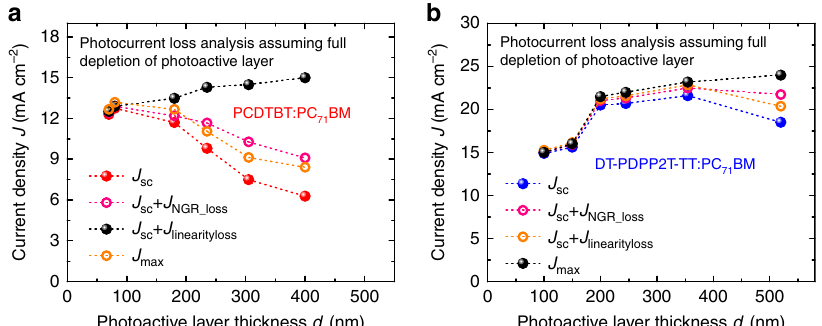
Fig. 2 Photocurrent analysis at short-circuit condition. a Photocurrents of PCDTBT:PC 71 BM are plotted device as a function of photoactive layer thickness: red balls are J sc measured under one sun solar simulator; black balls are J max measured photocurrent at reverse bias under on sun condition which represents the maximum photocurrent that can be generated at short circuit without any loss; orange and pink open circles are photocurrents added back the non-geminate loss and bimolecular linearity loss, respectively, both analyses relates to the consideration of the loss of photocurrent origins from bimolecular recombination. b Photocurrents of DT-PDPP2T-TT:PC 71 BM are plotted as a function of photoactive layer thickness. Similarly, the blue balls show the measured short-circuit currents, the black balls indicate the maximum photocurrent can be generated, the orange and pink open circles are the calculated photocurrents without measured bimolecular recombination